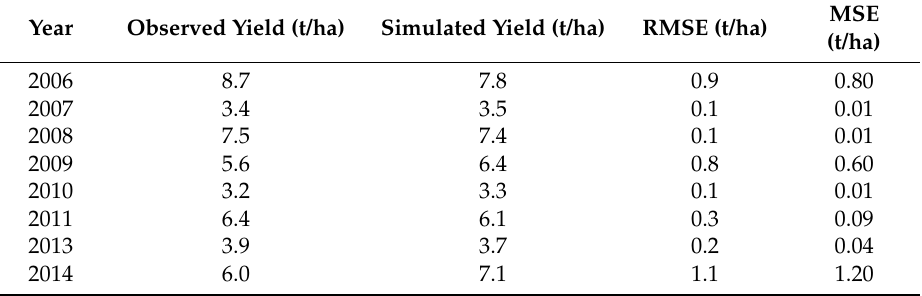
Table 5. The root mean square error (RMSE) and mean square error (MSE) value of the observed and simulated yield.